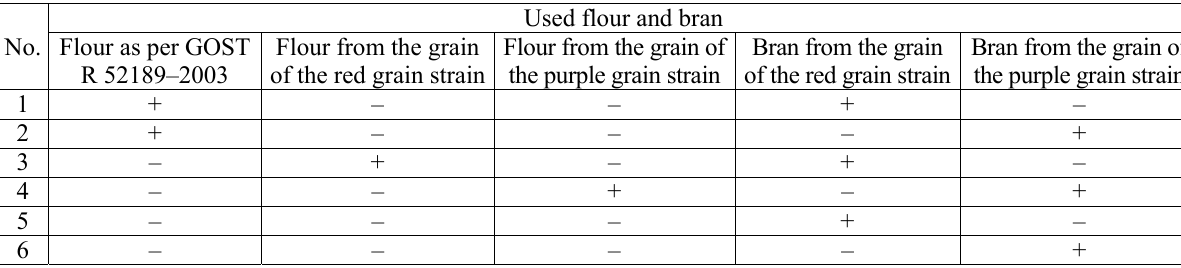
Table 1. Variants of products made and studied in the present